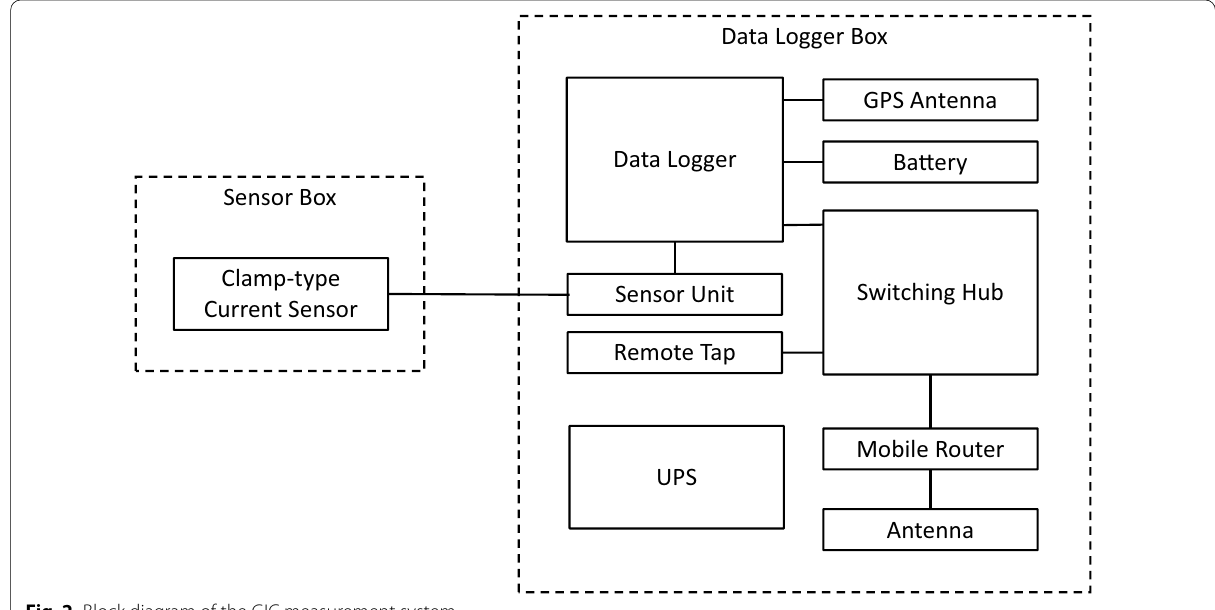
Fig. 2 Block diagram of the GIC measurement system